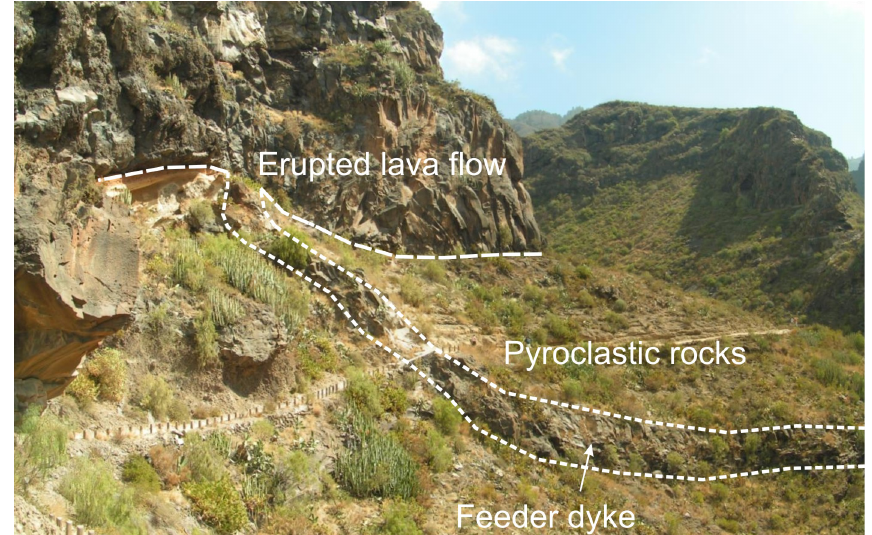
Fig. 4. Example of an inclined feeder dyke: the Infierno feeder dyke (Tenerife). As the dyke approached the surface it met a weak contact between two pyroclastic deposits and propagated into the contact – the contact being parallel with the stratification. However, just under the palaeo-surface the dyke turns and becomes perpendicular to the erupted lava